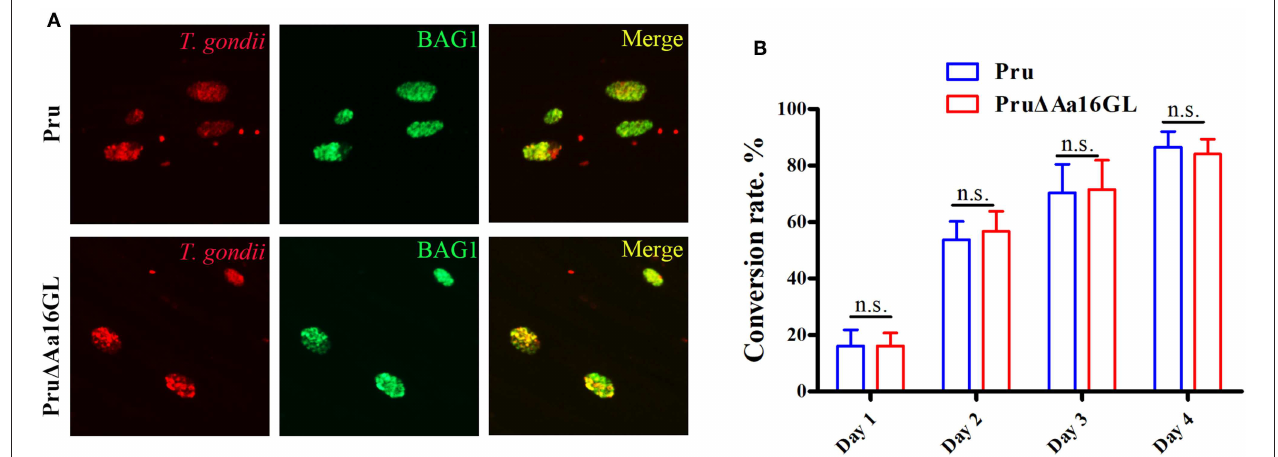
FIGURE 8 | Aa16GL is not necessary for cyst formation in vitro. (A) Parental Pru strain or Pru 1 Aa16GL mutant strain was allowed to infect HFF monolayers under alkaline conditions (pH 8.2, ambient CO 2 ) for 4 days. Cells were fixed and stained with goat anti- Toxoplasma gondii antibody (stain of total parasites), and rabbit anti-BAG1 (a bradyzoite specific marker). (B) Bradyzoite conversion rates of parental Pru strain or Pru 1 Aa16GL mutant at days 1, 2, 3, and 4 after induction of encystation. n.s, not significant, Student’s t